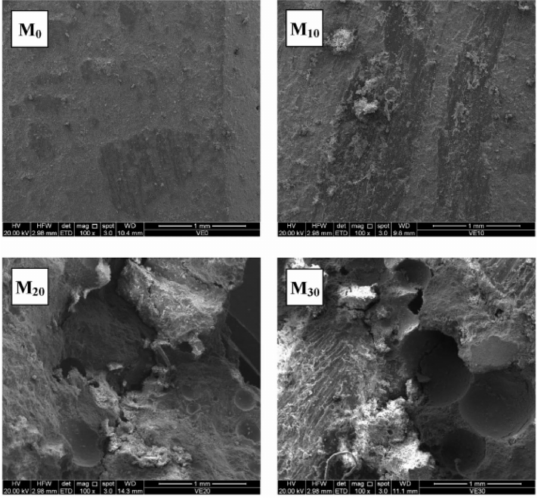
Figure 8. SEM images (100%) showing the morphologies of M 0 , M 10 , M 20 , and M 30 [62], with copyright permission from